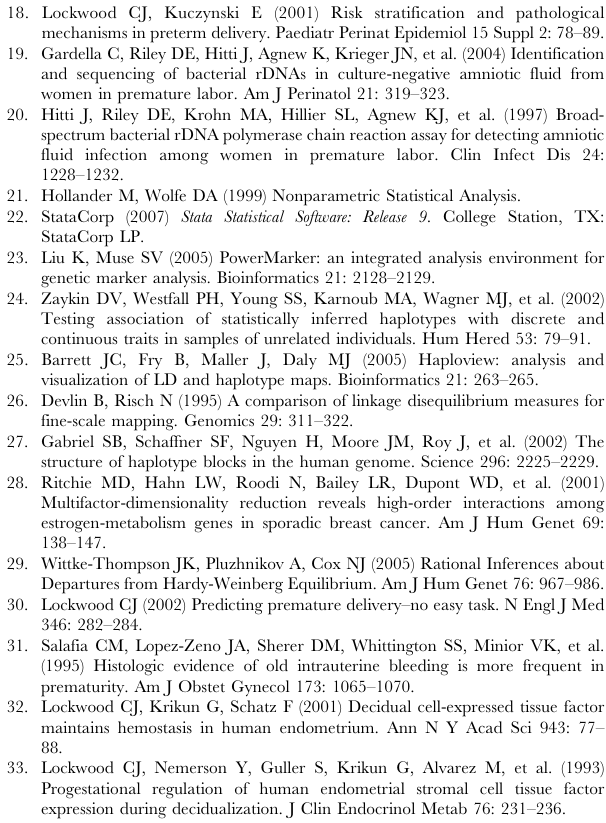
Figure S10 Maternal PTGER3 Controls Found at: doi:10.1371/journal.pone.0003283.s013 (0.24 MB DOC) Figure S11 Fetal CBS Cases Found at: doi:10.1371/journal.pone.0003283.s014 (0.05 MB DOC) Figure S12 Fetal CBS Controls Found at: doi:10.1371/journal.pone.0003283.s015 (0.05 MB DOC) Figure S13 Fetal IL-10RA Cases Found at: doi:10.1371/journal.pone.0003283.s016 (0.04 MB DOC) Figure S14 Fetal IL-10RA Controls Found at: doi:10.1371/journal.pone.0003283.s017 (0.04 MB DOC) Figure S15 Fetal TREM1 Cases Found at: doi:10.1371/journal.pone.0003283.s018 (0.04 MB DOC) Figure S16 Fetal TREM1 Controls Found at: doi:10.1371/journal.pone.0003283.s019 (0.04 MB